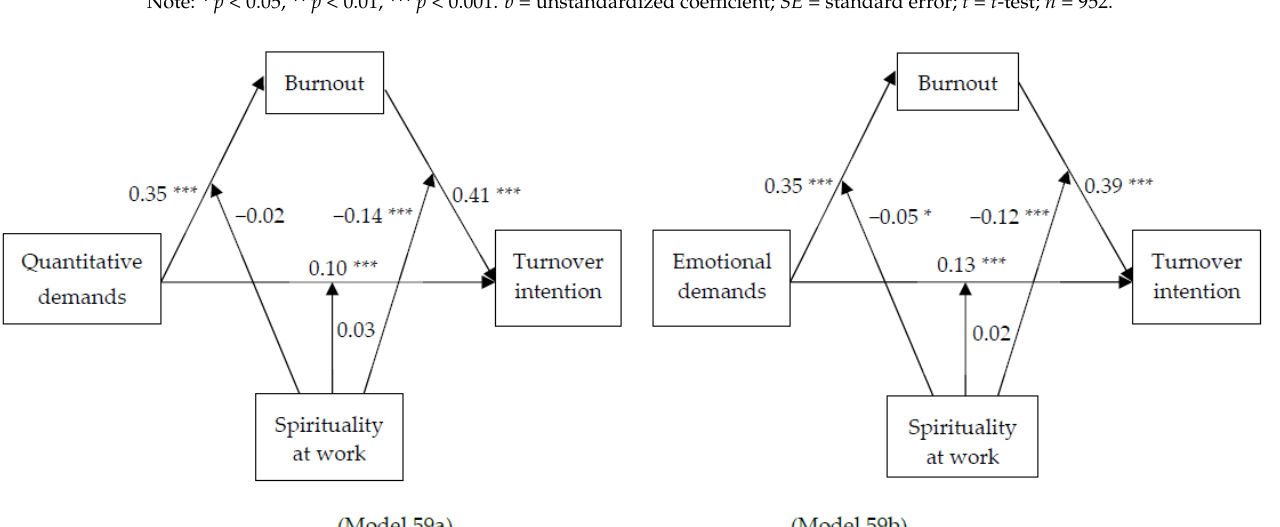
Figure 3 . Model 59a: Moderating effect of spirituality on the relationship between burnout and turn- over intention. M − 1 SD = one standard deviation below the mean; M = mean; M + 1 SD = one stand- ard deviation above the mean. Burnout and spirituality were mean-centered before creating a prod- uct term.